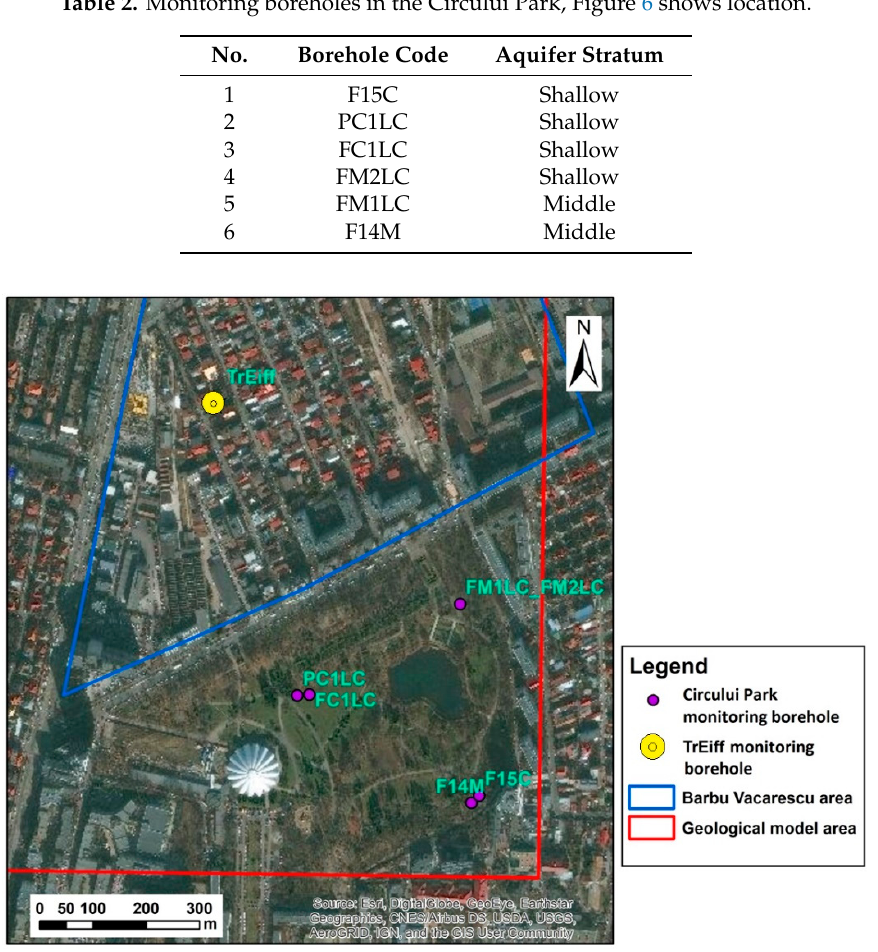
Table 2. Monitoring boreholes in the Circului Park, Figure 6 shows location.